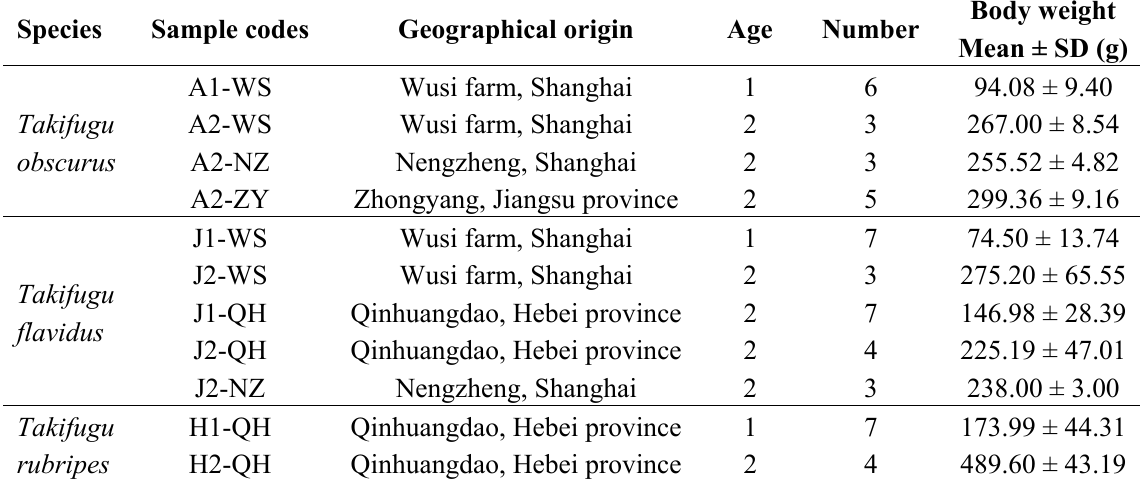
Table 1. Background information on the 11 puffer fish groups